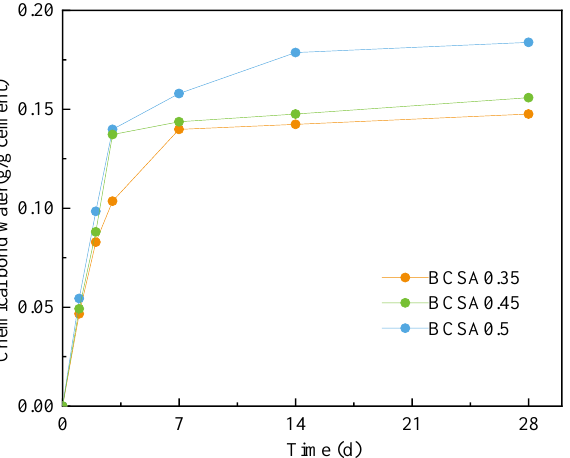
Figure 3. Chemically bound water content of BCSA cement pastes at days 1 – 28.